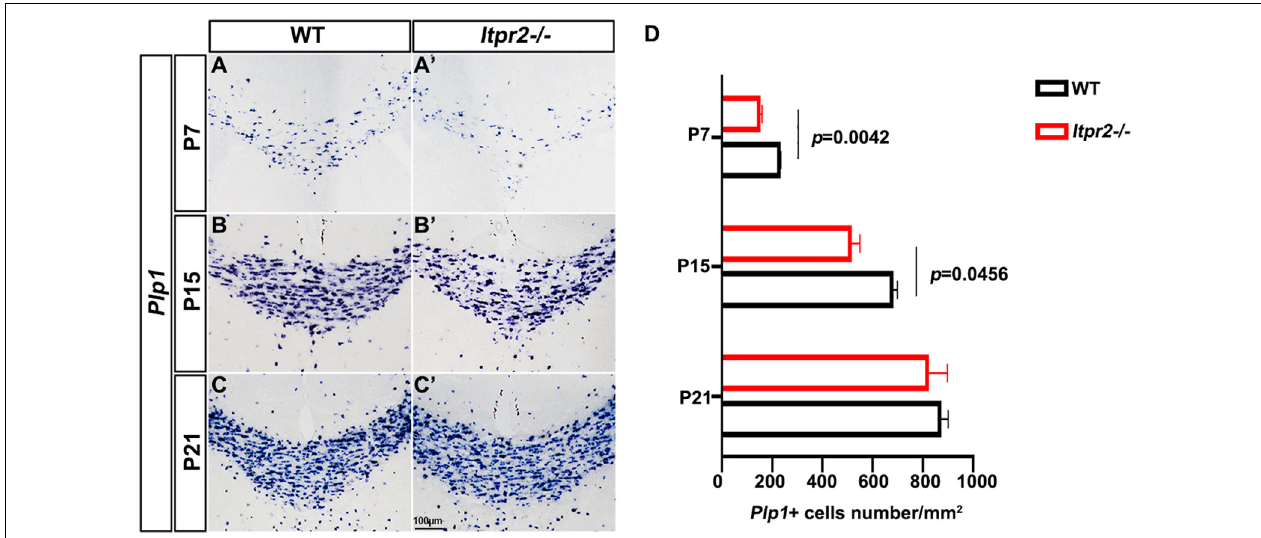
FIGURE 2 | Ablation of Itpr2 gene delays the differentiation of oligodendrocytes. (A–C (cid:48) ) Plp1 mRNA expression in coronal forebrain sections of wild-type (A–C) and Itpr2 - KO (A (cid:48) –C (cid:48) ) mice at indicated stages. (D) Quantification of Plp1 + cells per section ( n = 3) in the corpus callosum of Itpr2KO mice. Error bars indicate Means ± SEM. Scale bar represents 100 µ